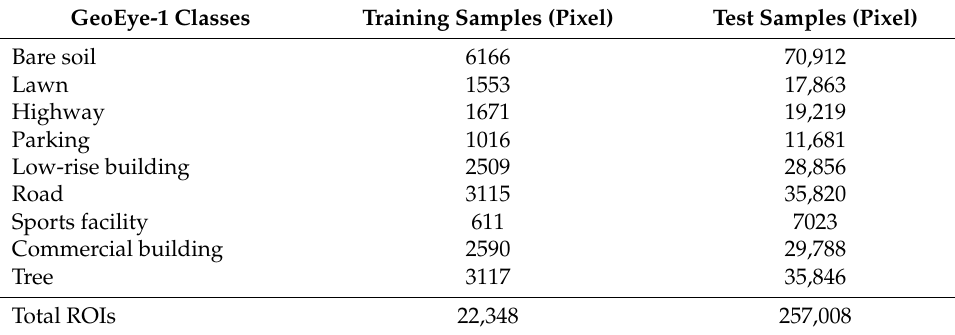
Table A4. Training and test samples for each class in the Hobart image.